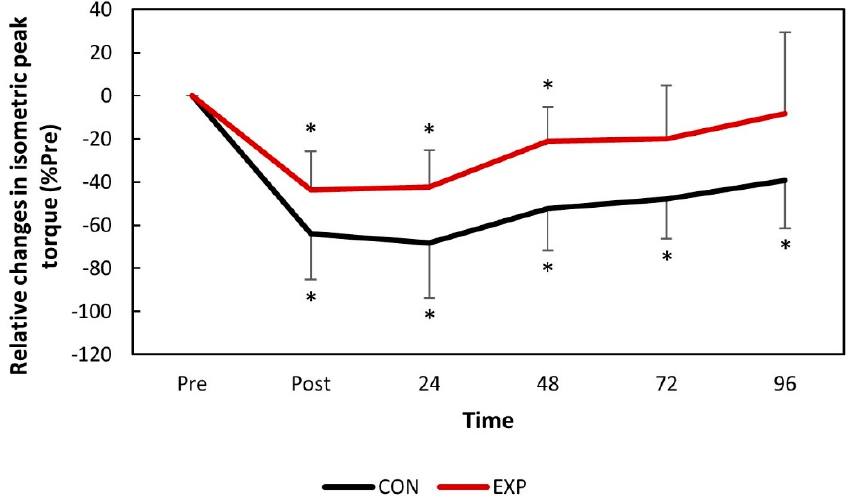
Figure 3. The relative changes in isometric peak torque over time following downhill running. * p < 0.05 compared to the baseline values in the same group. CON: control group; EXP: experimental group.